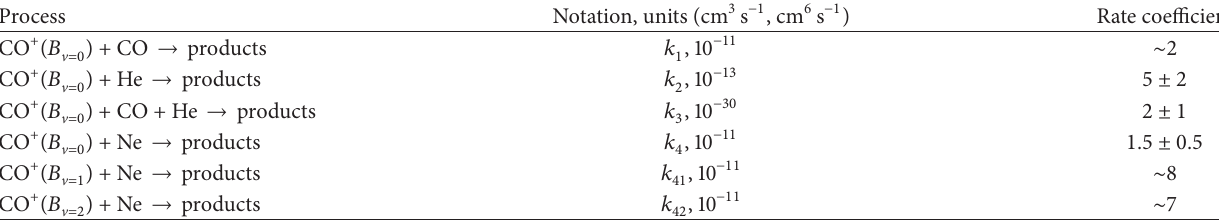
Table 2: Rate constants of CO + (B) quenching [53].